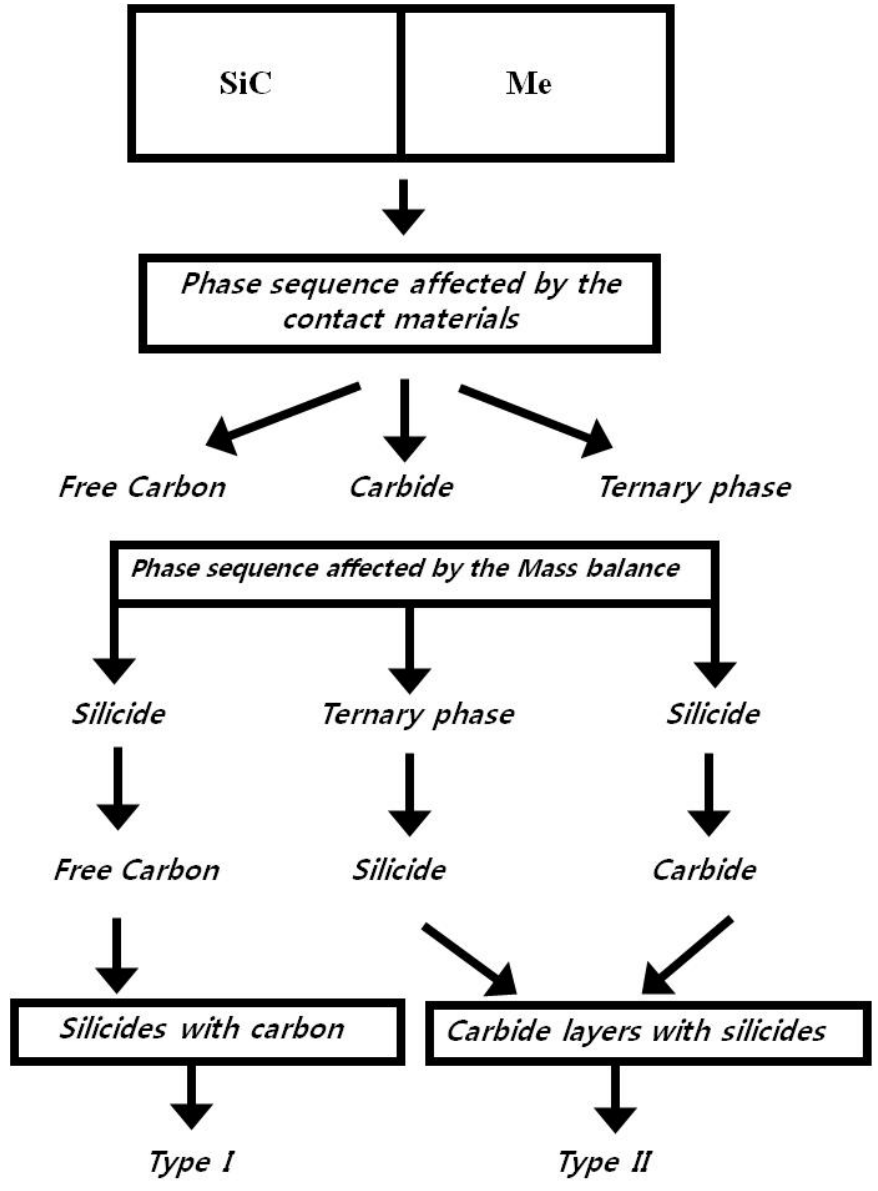
Figure 3. Schematic figure showing the sequence of the products with respect to the contact materials